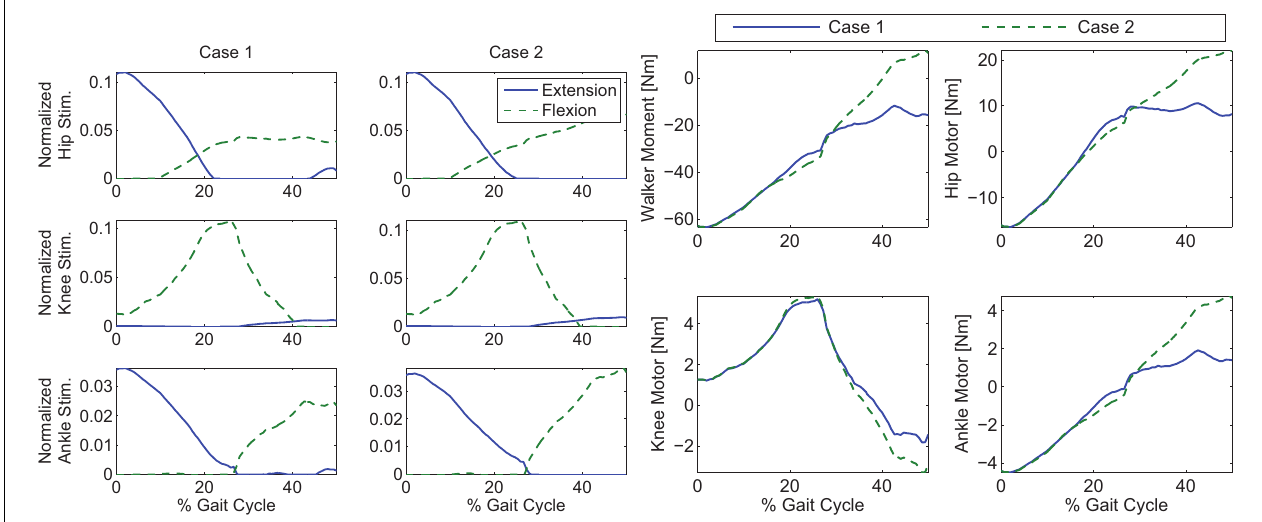
FIGURE 7 | Control inputs for Cases 1 and 2 of the simulations . Note that the control input profile shapes, after PCA decomposition, in Case 1 may not be similar to the optimal inputs in Figure 3 .